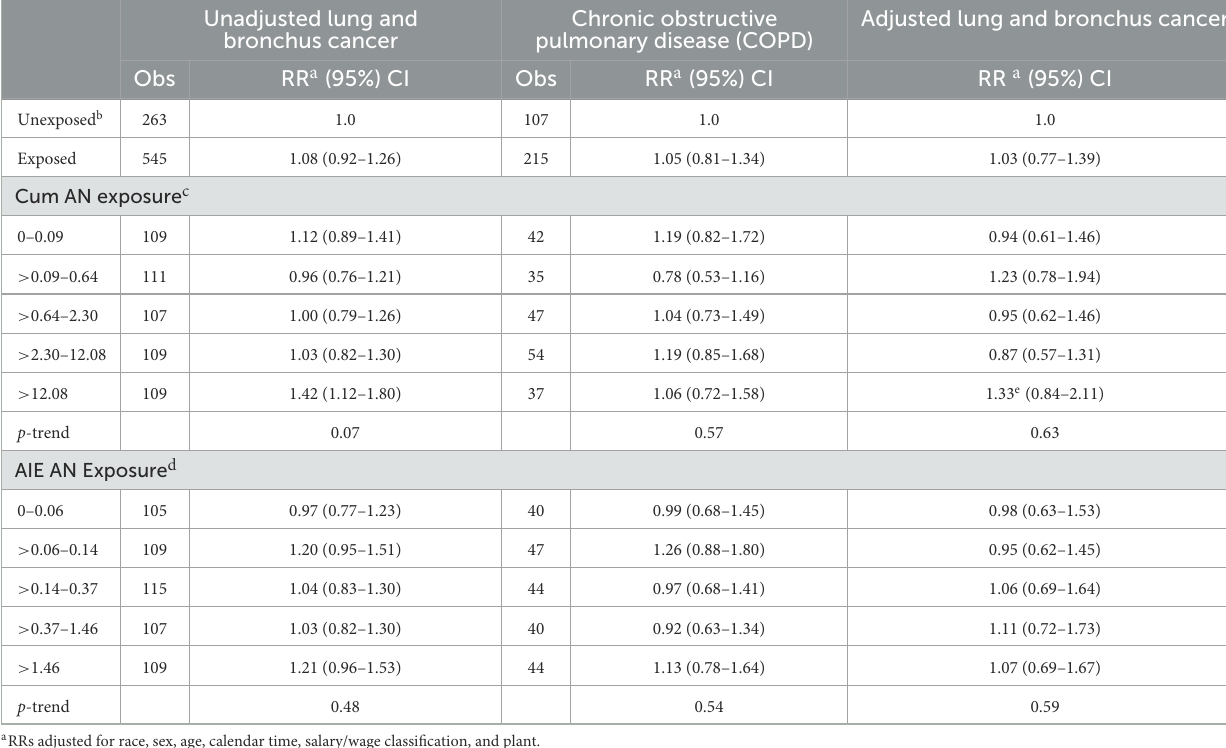
TABLE 4 UPitt Lung and bronchus cancer relative risks (RR) in relation to AN exposure adjusted for potential confounding by smoking using the Richardson method, full cohort, 1942–2011. Unadjusted lung and Chronic obstructive Adjusted lung and bronchus cancer bronchus cancer pulmonary disease (COPD)